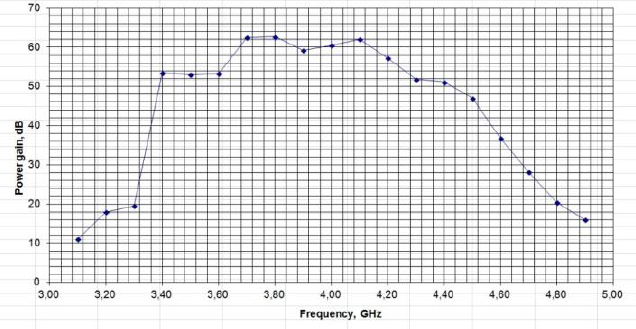
Fig. 1. The characteristic of low-noise microwave amplifier. Noise Band 0.8 GHz.